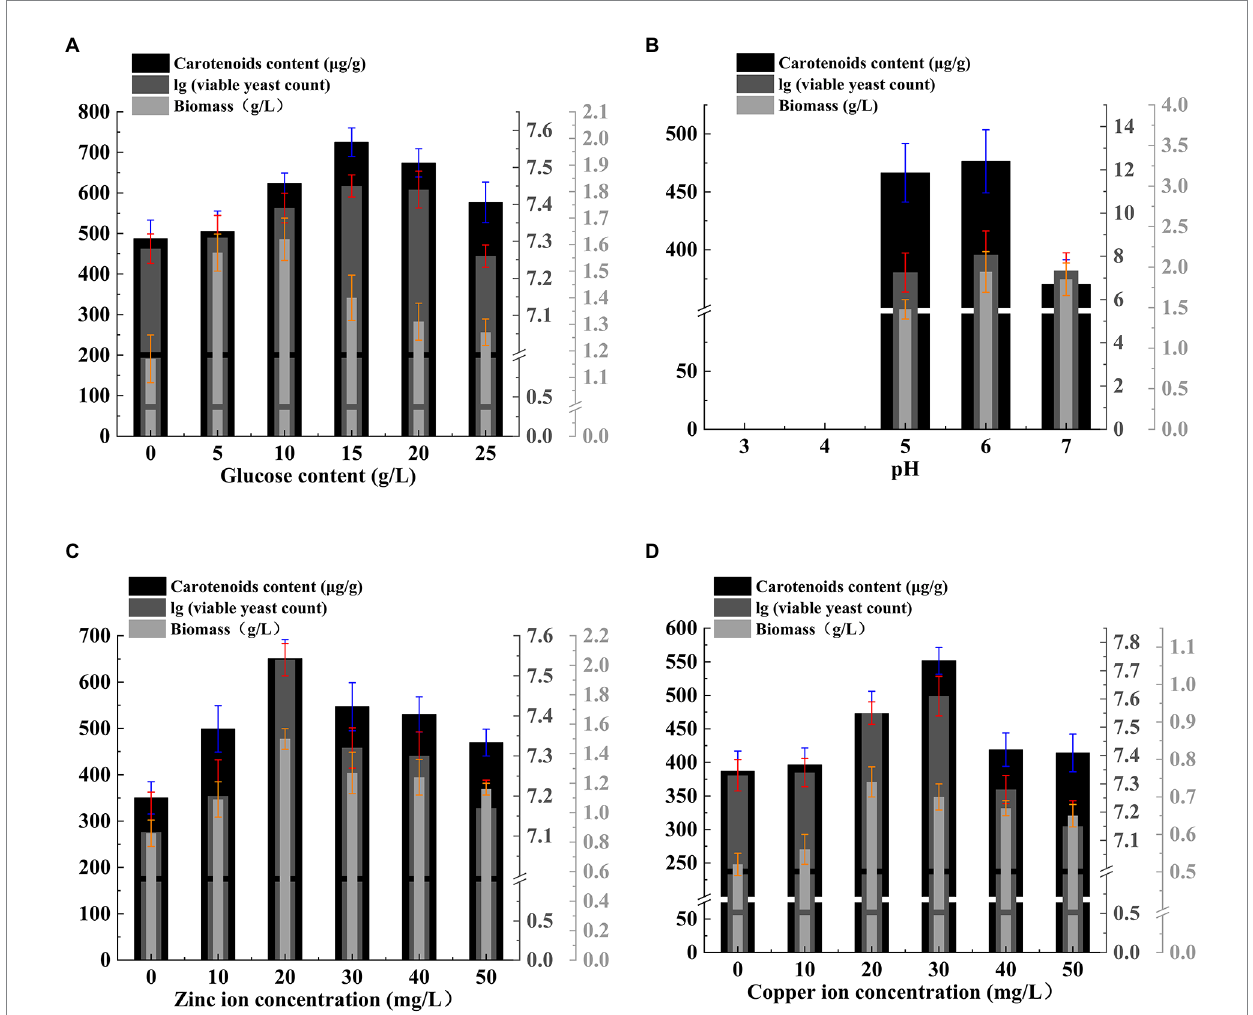
FIGURE 1 Effect of factors on carotenoids content, biomass and viable yeast count. (A) glucose, (B) pH, (C) zinc ion, (D) copper